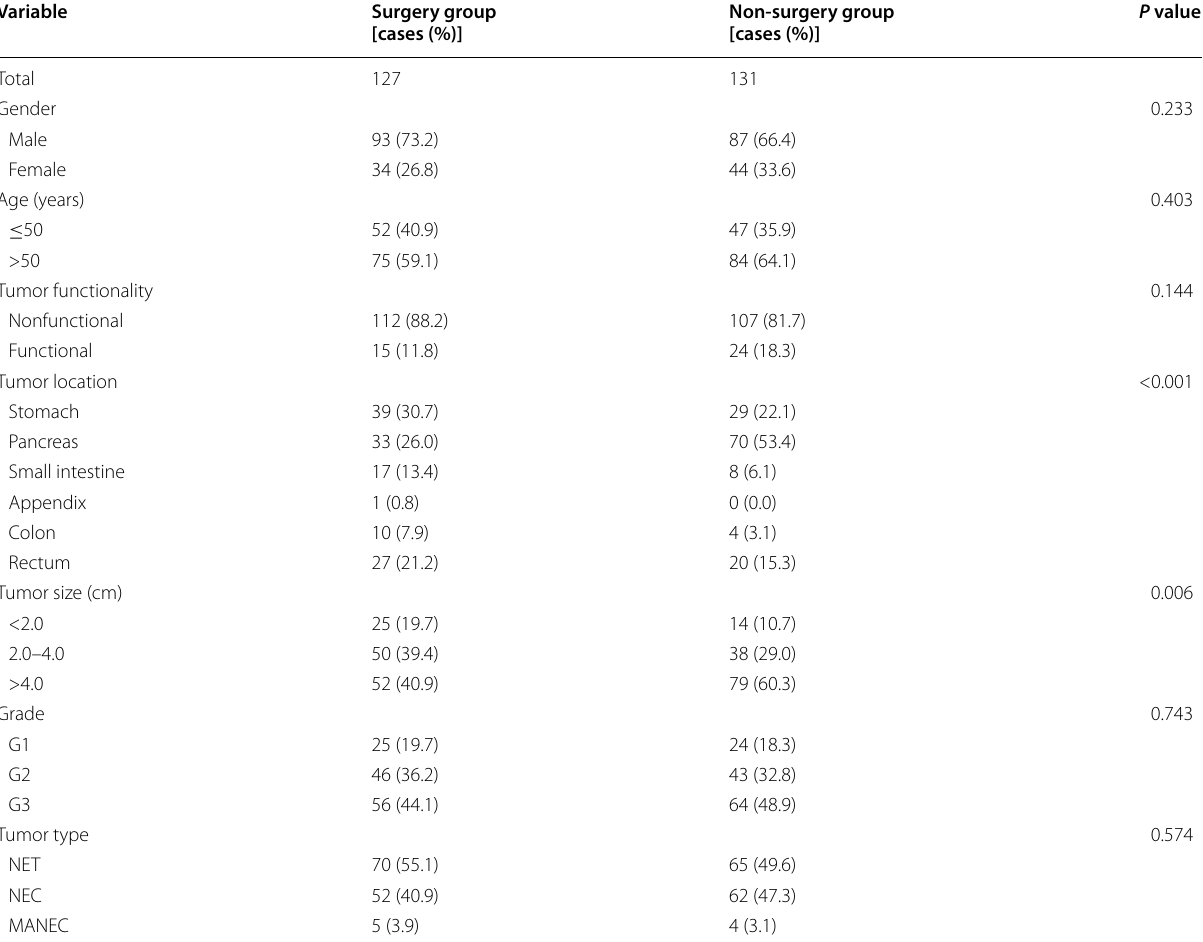
Table 2 Chi-square analysis for clinicopathologic variables in patients with M1 category GEP-NENs who did or did not undergo